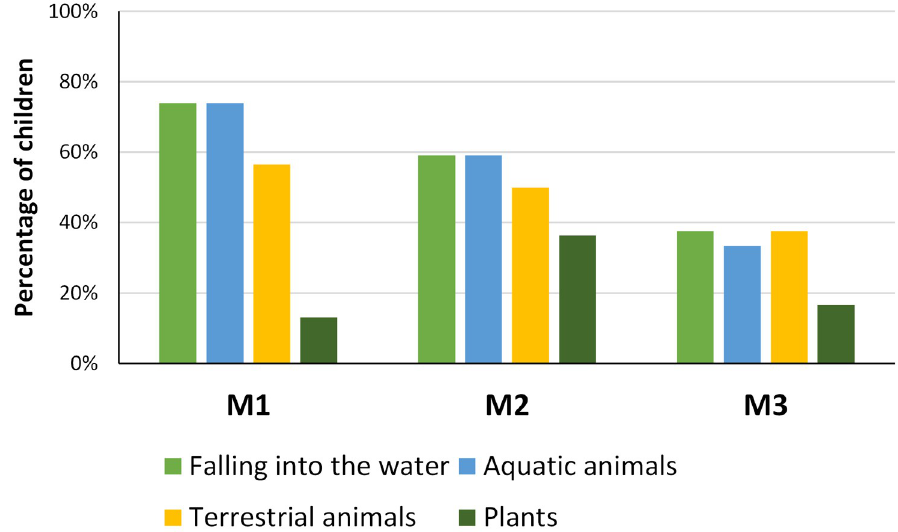
Fig 2. Percentage of children referring dangers in the rivers/streams (falling into the water, aquatic animals, terrestrial animals, and plants) over time in the questionnaires (M1-M3).